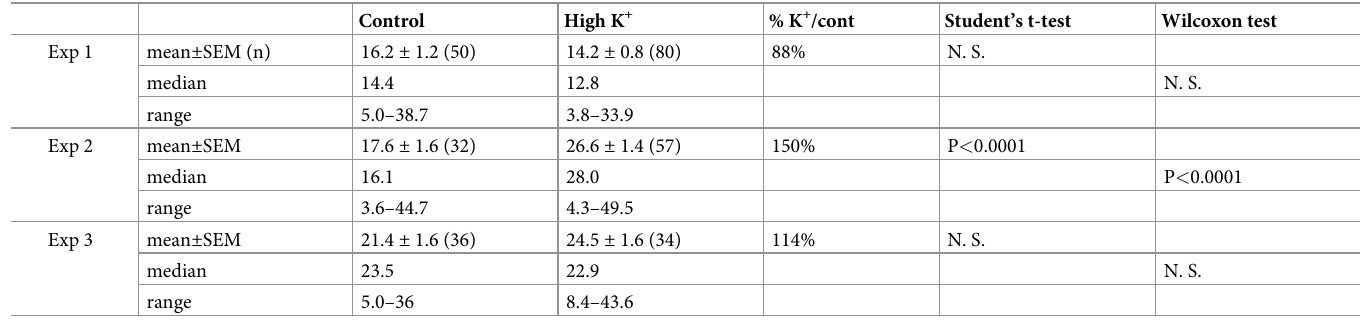
Table 1. Density of label for densin at the PSD (number of gold particles per μ m PSD).